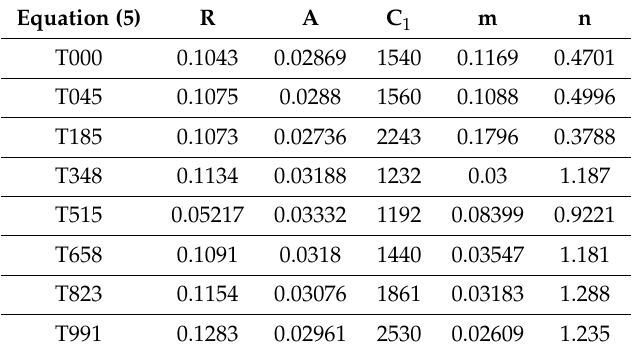
Table 6. Fitted model parameters in Equation